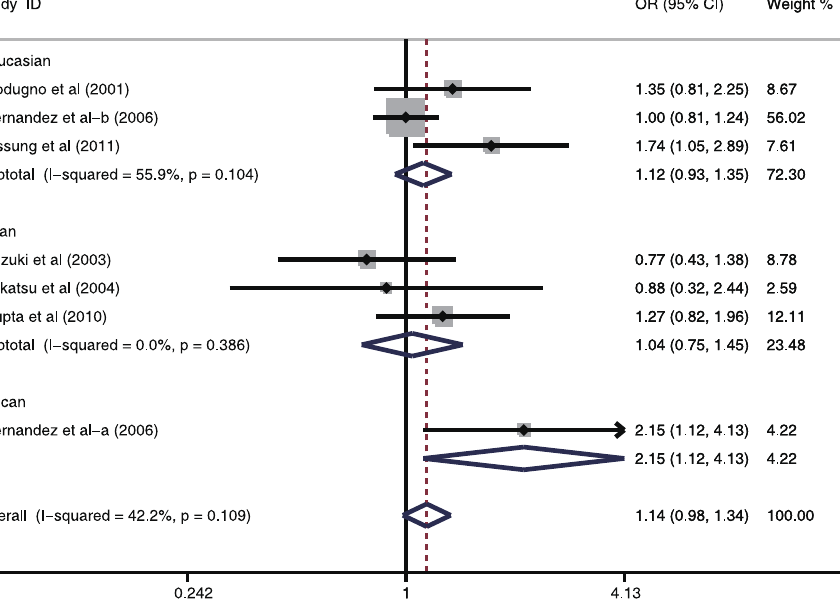
Figure 4. Subgroup analysis by ethnicity of ORs with a random-effects model for associations between ESR1 XbaI (A . G) polymorphism and prostate cancer risk under dominant model (GG + AG vs. AA).